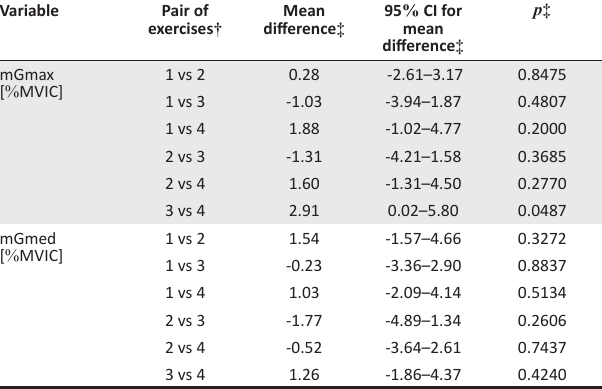
TABLE 4 : Pairwise mean differences between exercises for gluteus maximus and gluteus medius % maximal voluntary isometric contraction.